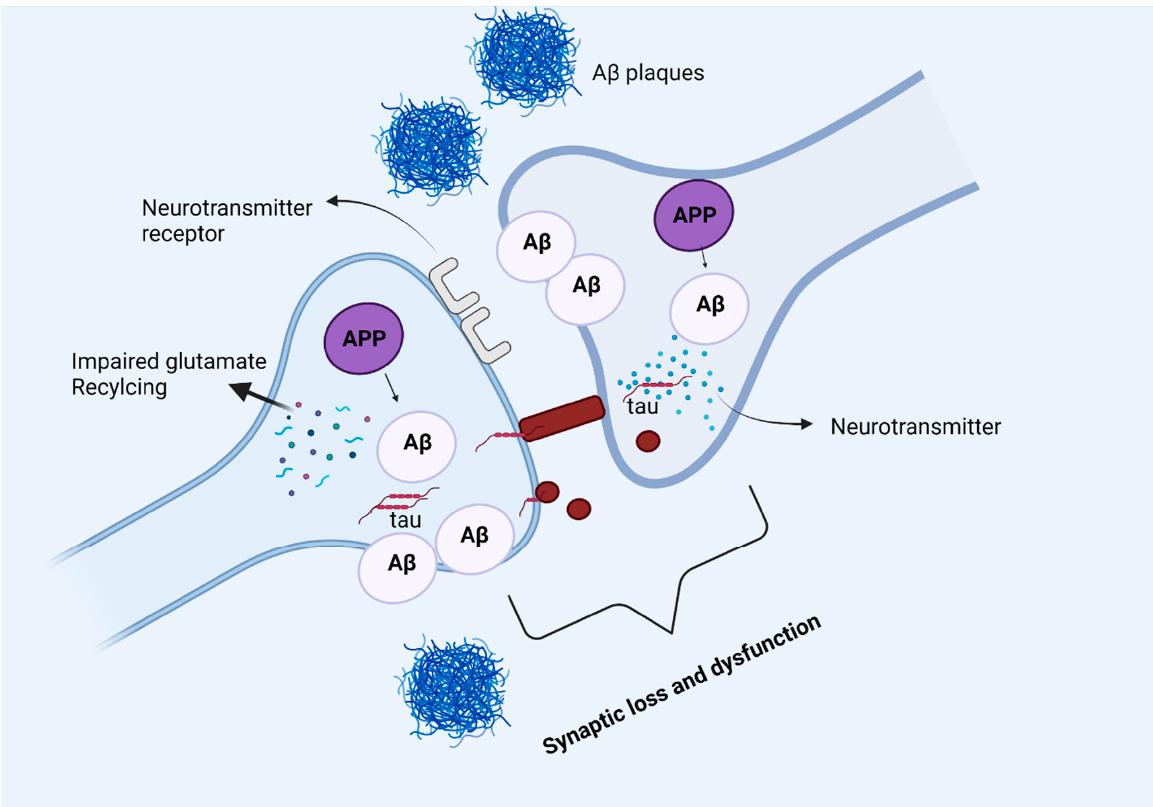
Figure 5. Amyloid beta and tau protein at the synapse. In Alzheimer’s disease, amyloid precursor protein is processed into amyloid beta peptides that accumulate inside and outside the neuronal cells and form plaques. The deposition of amyloid plaques in the vicinity of the synapse causes synaptic loss and dysfunction. Moreover, glutamate recycling is also dysregulated in the presence of pathological amyloid beta levels in neurons. The soluble, hyperphosphorylated tau protein can directly move across the plasma membrane, or by another mechanism where the formation of nanotubules helps the translocation of tau intracellularly. The synergetic pathology of A β and tau at synapse causes synaptic loss and dysfunction.